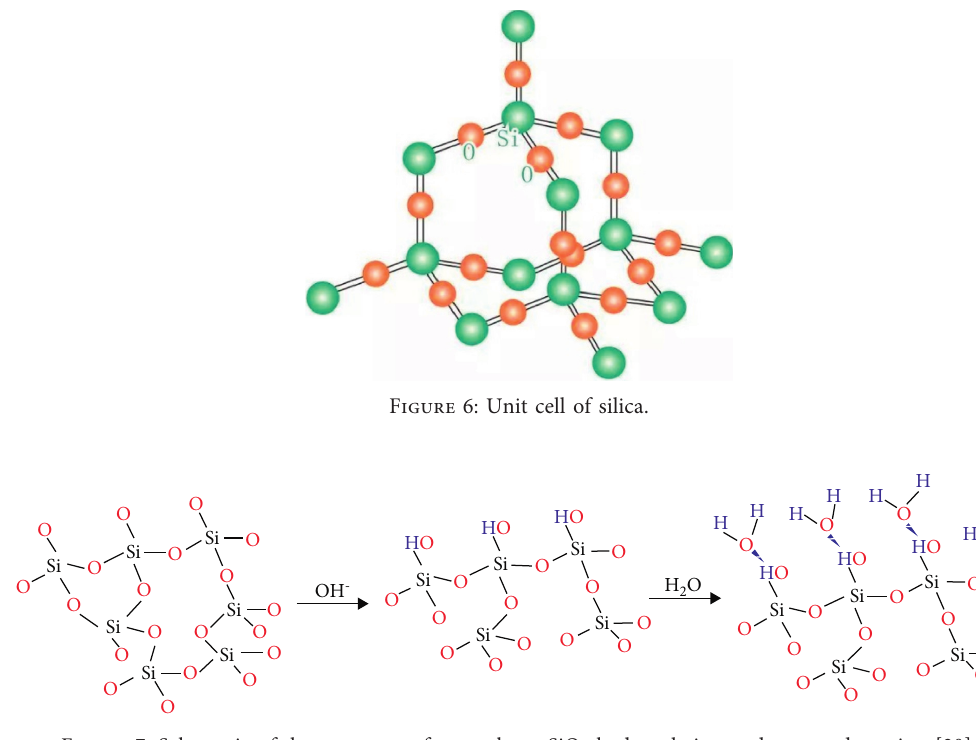
2 hydroxylation and water adsorption